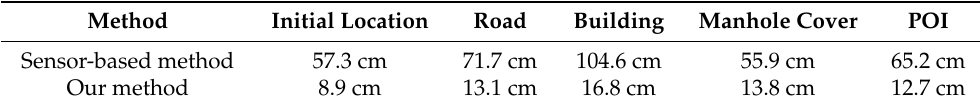
Table 7. Error comparison of the two visualization methods in real